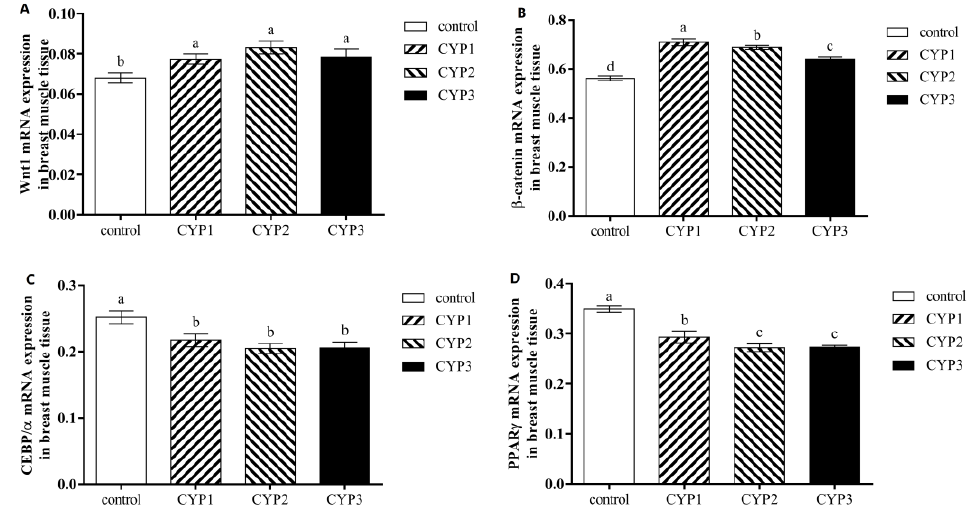
Figure 2. The Wnt1 ( A ), β -catenin ( B ), CEBP α ( C ), and PPAR γ ( D ) mRNA expressions in breast muscle of broilers. Control, CYP1, CYP2, CYP3, PPAR γ , and C/EBP α same for Figure 1. a,b,c The difference between the small letters indicates a significant difference ( p < 0.05).